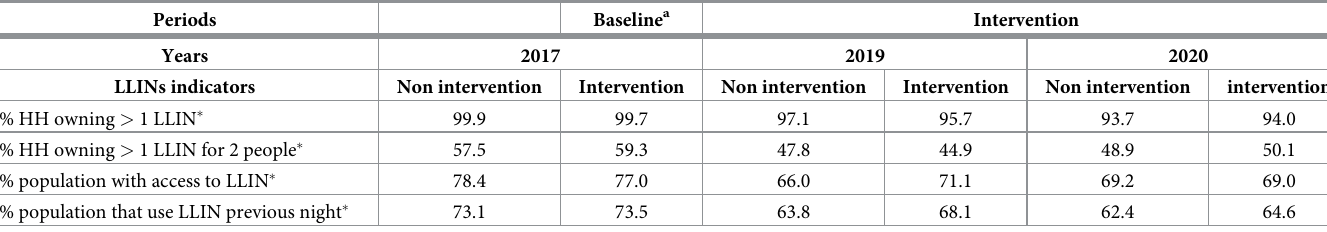
Table 3. Ownership, access and usage of LLINs before and during the larviciding intervention.